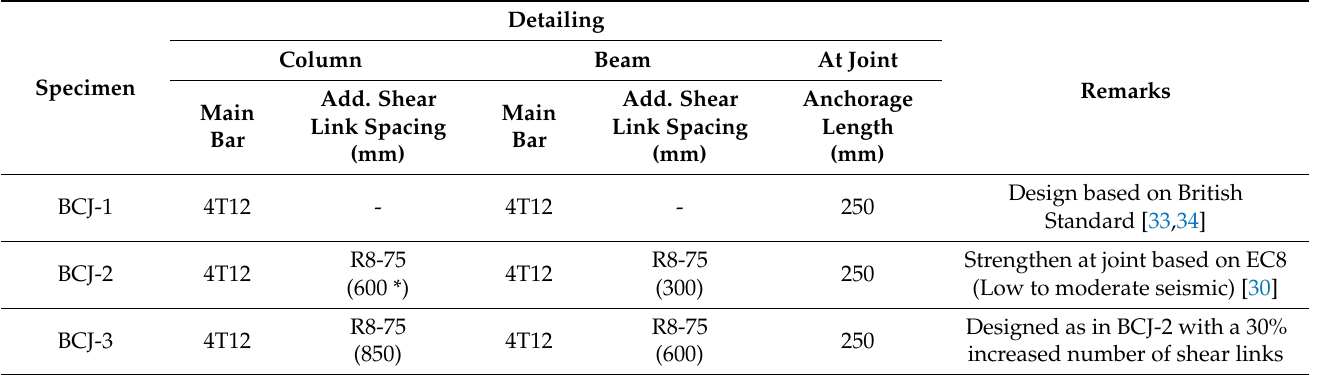
Table 1. The designed detailing of